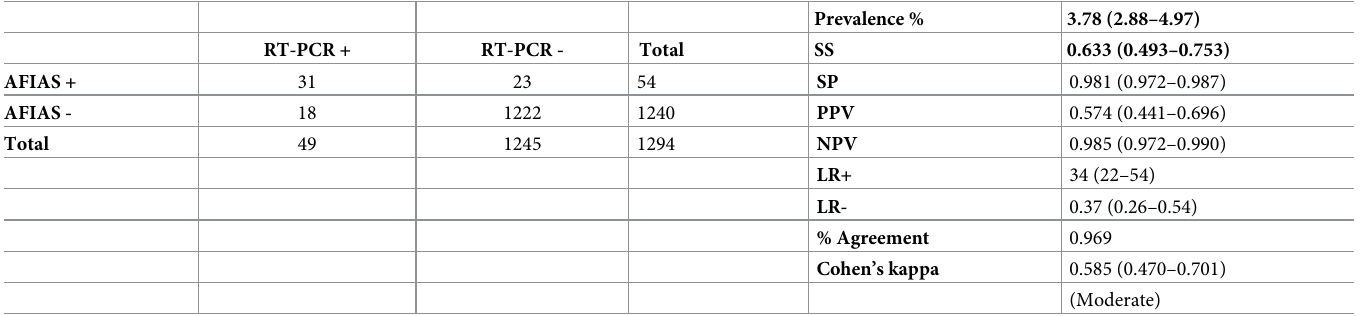
Table 1. Diagnostic accuracy of AFIAS COVID-19 Ag test assessed against RT-PCR assay.